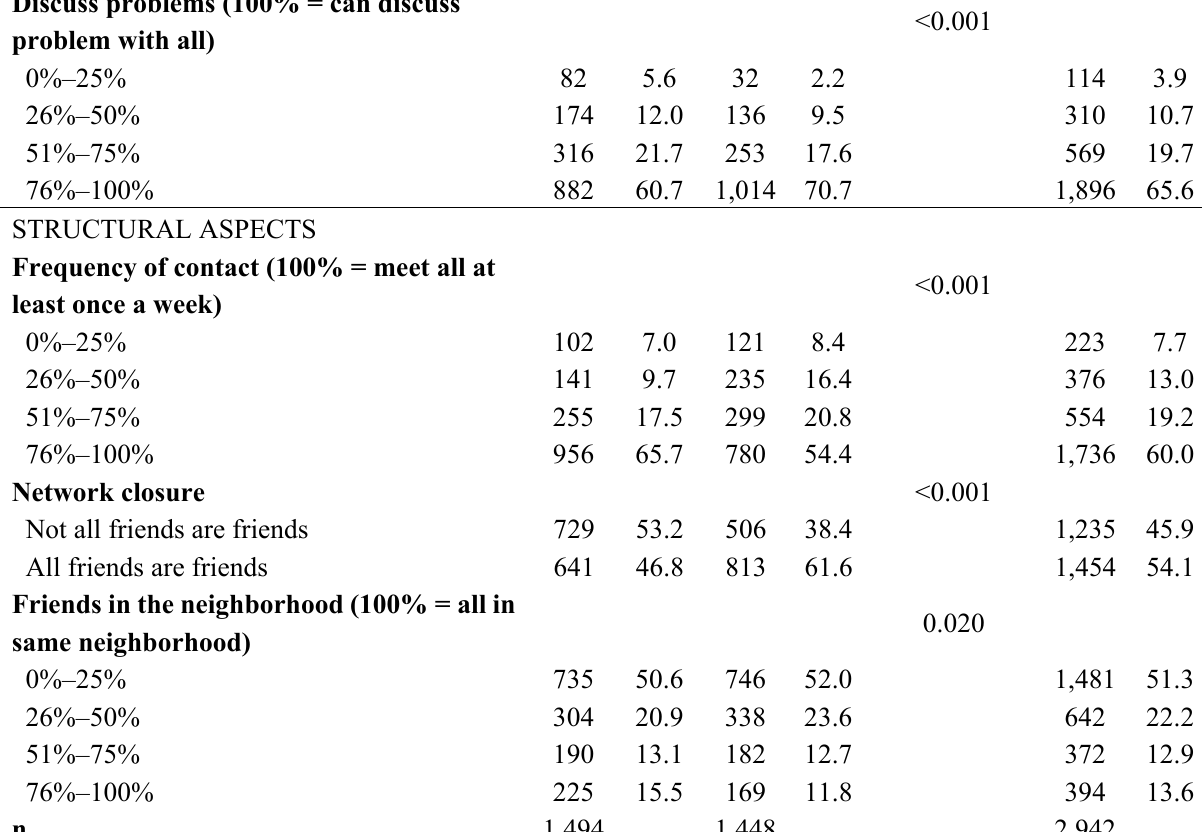
Table 3. The association between network characteristics and daily smoking among